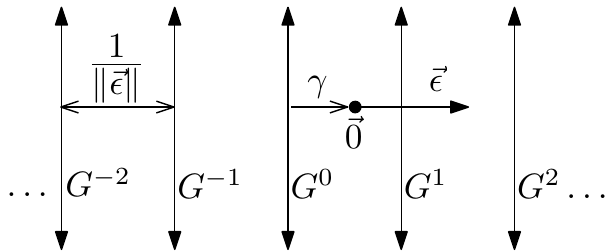
Figure 5. The grid as a set of parallel planes G k indexed by k ∈ Z . (cid:126) (cid:101) is the norm vector and γ is the shift of the